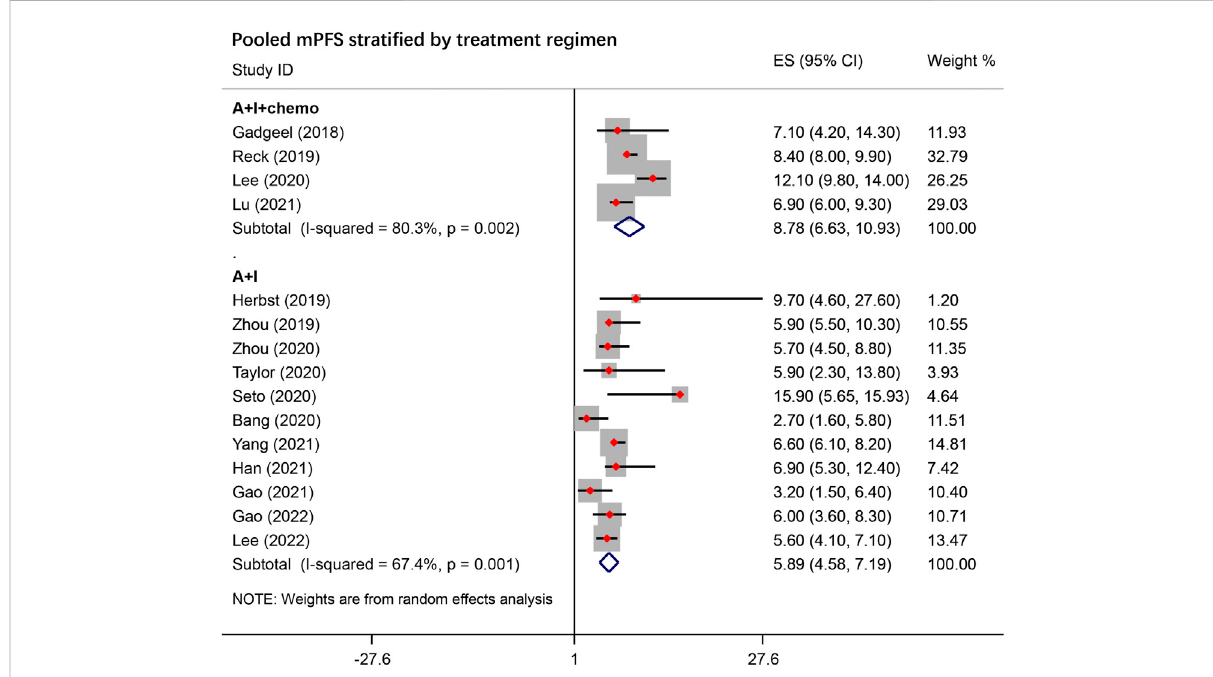
FIGURE 3 Pooled median progression-free survival (mPFS) strati fi ed by treatment regimen. A + I + chemo group: antiangiogenic agents combined with ICIs with chemotherapy; A + I group: antiangiogenic agents combined with